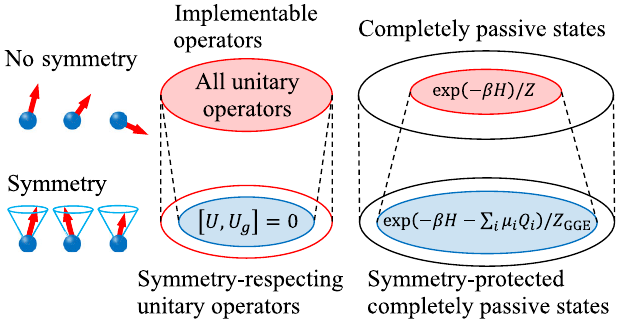
FIG. 1. Symmetry constraints on unitary operations and com- pletely passive states. When the class of allowed operations is restricted, the class of quantum states from which positive work cannot be extracted is expanded. This leads to the question of identifying the states that behave as effective thermal equilibrium under symmetry constraints. In this paper, we completely identify the class of such effective thermal equilibrium states, which we name as symmetry-protected thermal equilibrium states, by prov- ing that those states are always given by GGEs of the form Eq. (1), including the case that the conserved charges are